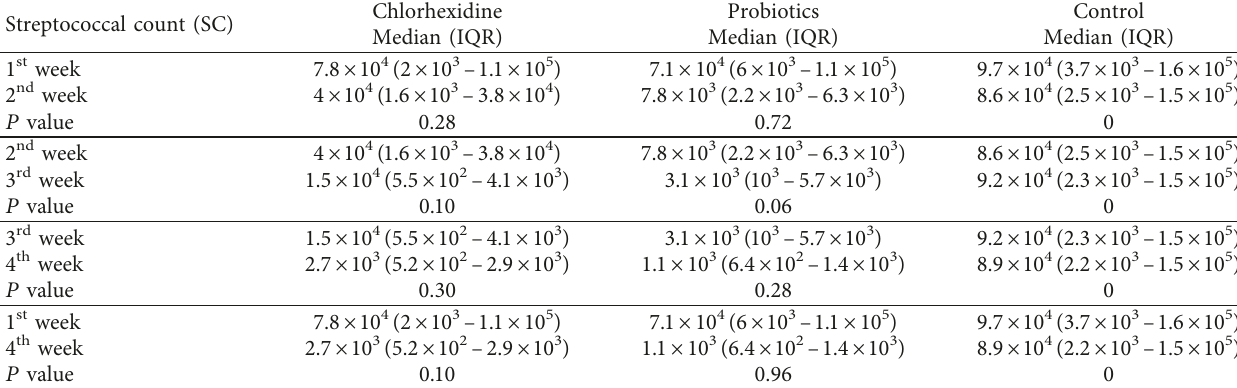
Table 3: Comparison of the median streptococcal colony count scores between the